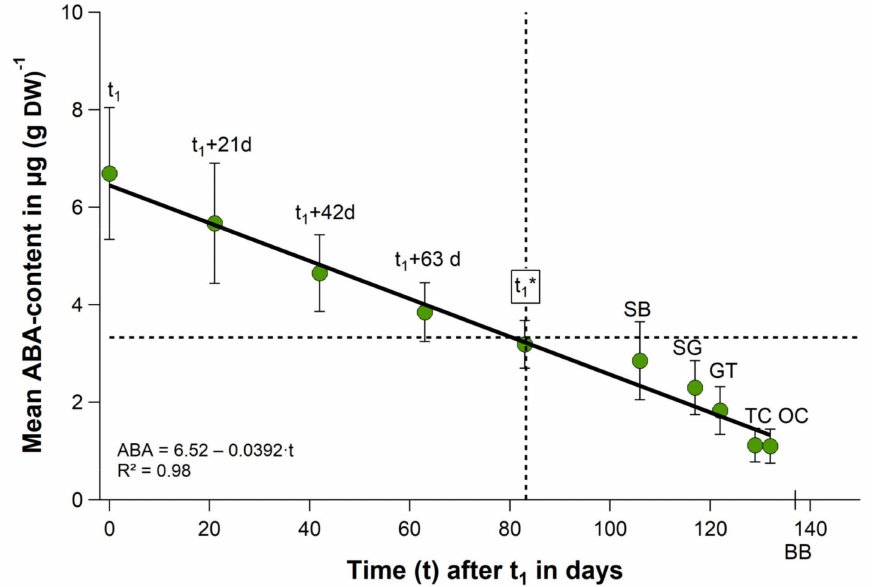
Figure 4. Mean ABA content of ‘Summit’ cherry flower buds from t 1 until OC (2011/12–2018/19). Error bars show the standard deviation of 8 years, t 1 : endodormancy release, t 1 *: beginning of ontogenetic development, SB: ‘swollen bud’, SG: ‘side green’, GT: ‘green tip’ TC: ‘tight cluster’,